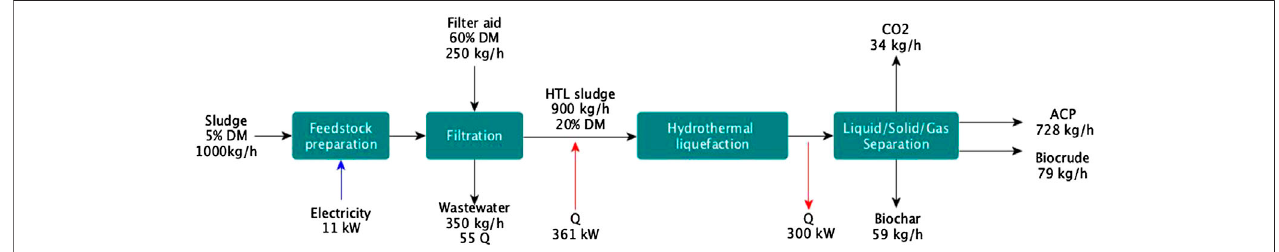
FIGURE 2 | Hydrothermal liquefaction schematic representation.